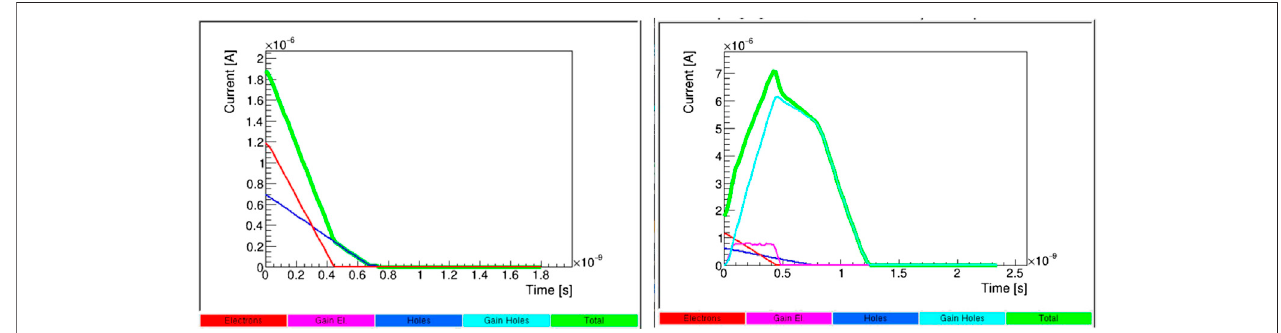
FIGURE 5 | Left (Right), Weight fi eld2 simulations of the signal generated by a mip crossing a 50 μ m thick diode (LGADs with gain (cid:2) 10). V (cid:2) 200 V. The different contribution to the current of electron, holes, multiplied holes and multiplied electrons are